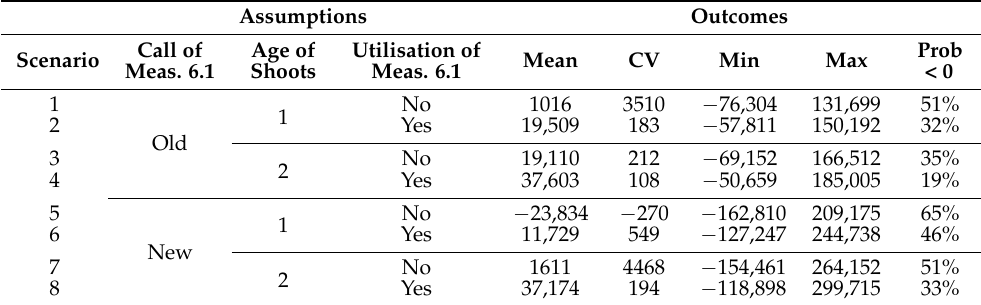
Table 5. Results of the stochastic estimation of the net present value (NPV) per scenario.